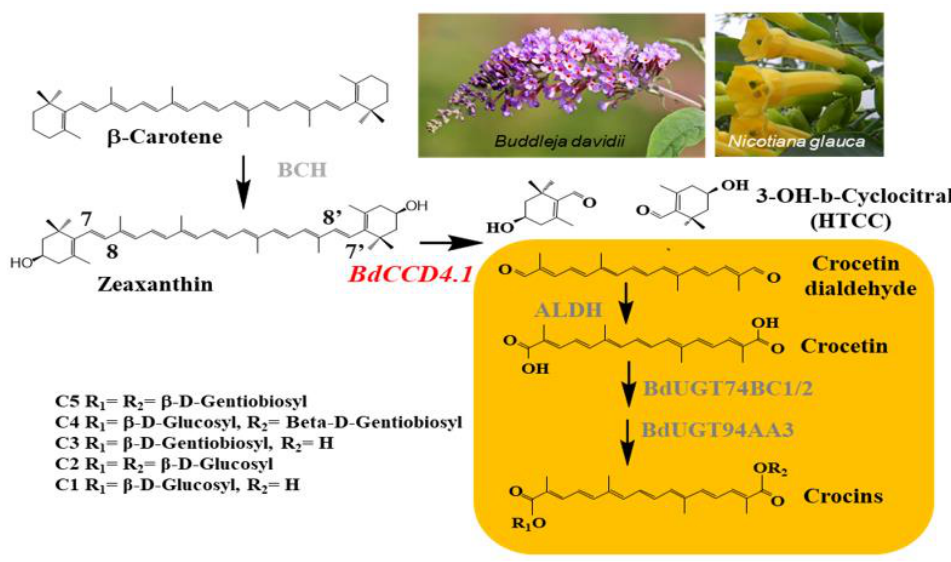
Figure 1. Biosynthetic pathway of crocins from zeaxanthin in Buddleja davidii . Pictures of B. davidii and N. glauca petals are shown in the upper right. The recombinant enzyme introduced in N. glauca under the control of the CaMV35S promoter is shown in red. The yellow background shows the stages of transformation of crocetindial into the different crocins present in the petals of B. davidii . The arrows show each of the conversion steps catalyzed by the corresponding enzyme in gray. The different substitutions for the crocins present in the petals of B. davidii are shown in the lower left.